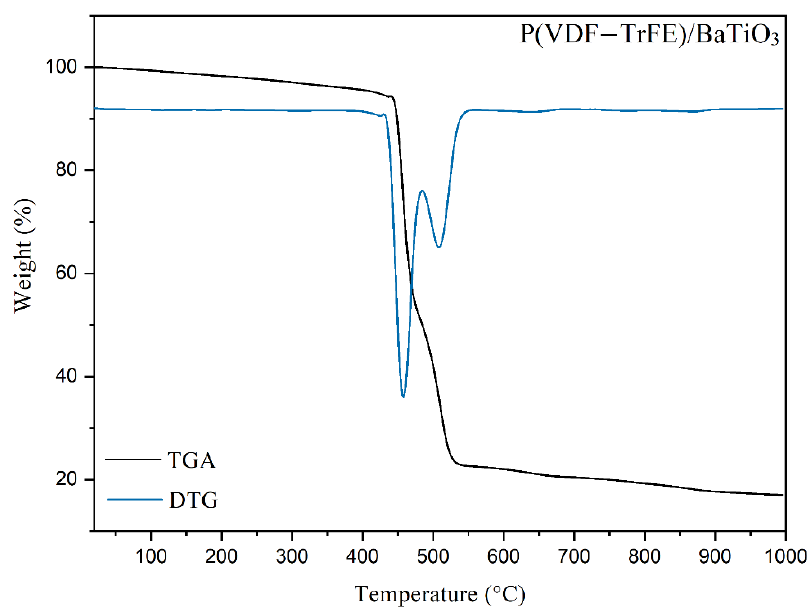
Figure 4. Thermal behavior of P(VDF-TrFE)/BaTiO 3 film and your derivative at 20 °C to 1000 °C.